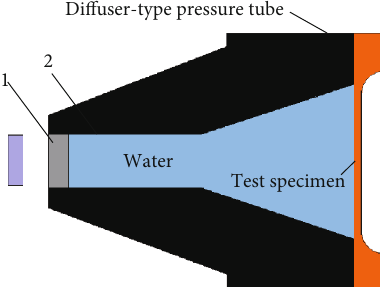
Figure 5: Schematic of water chamber with divergent di ff user. 1- Steel projectile; 2-Al piston; 3-water; 4-steel tube; 5-test